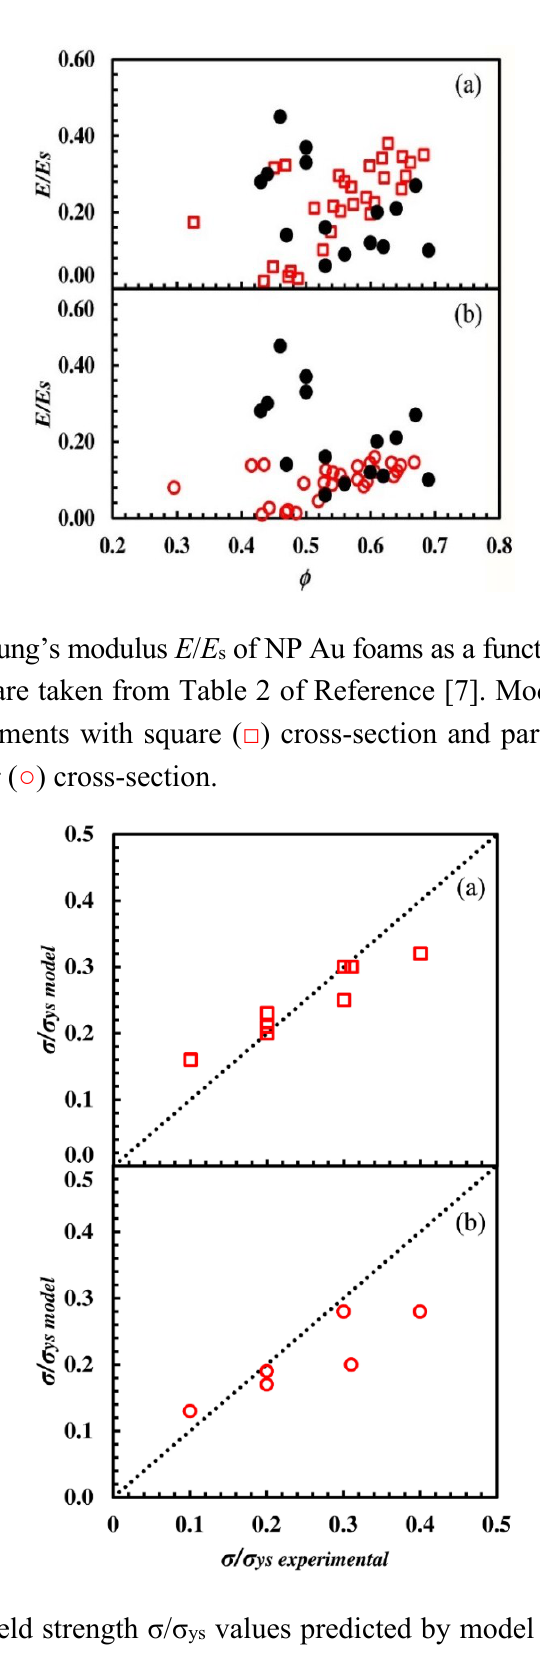
Figure 13. Relative yield strength σ/σ ys values predicted by model equations as a function of experimental estimates. Experimental data are taken from References [3,90,95]. Model predictions: part ( a ) shows the case of ligaments with square (□) cross-section and part ( b ) shows the case of ligaments with circular (○)